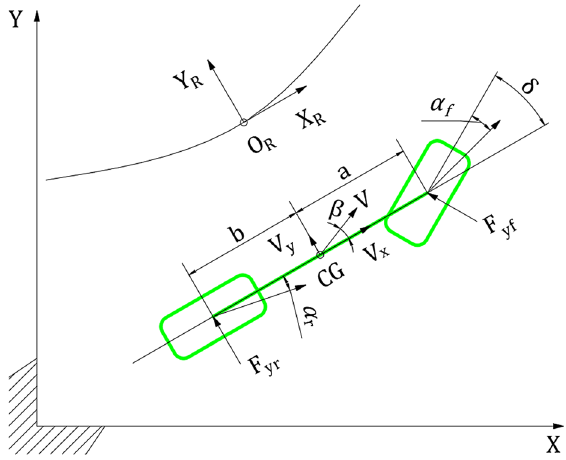
Figure 1. DDAV path tracking dynamic